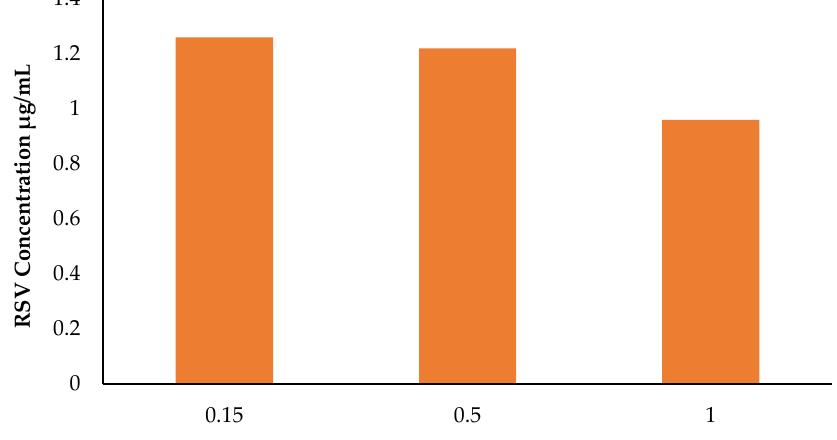
Figure 15. Reduction of reconstitution volume of H 2 O added after lyophilization (mL).